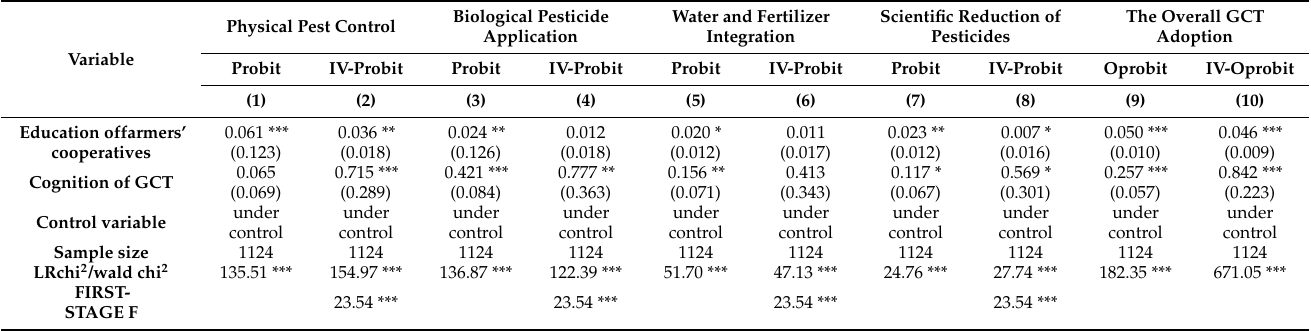
Table 7. Test of the mediating effect of green prevention and control